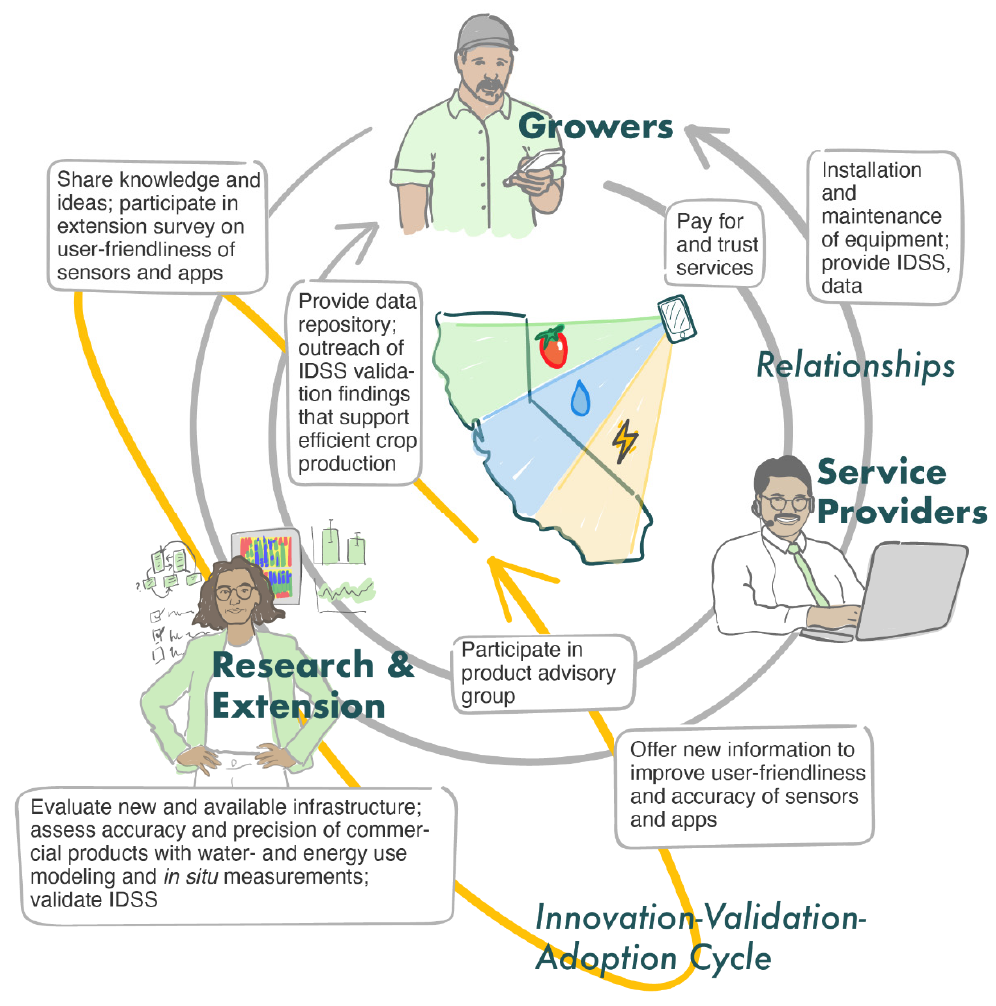
Figure 4. Innovation–adoption–validation cycle of irrigation decision support system. Artwork by Dr. Bonnie McGill.